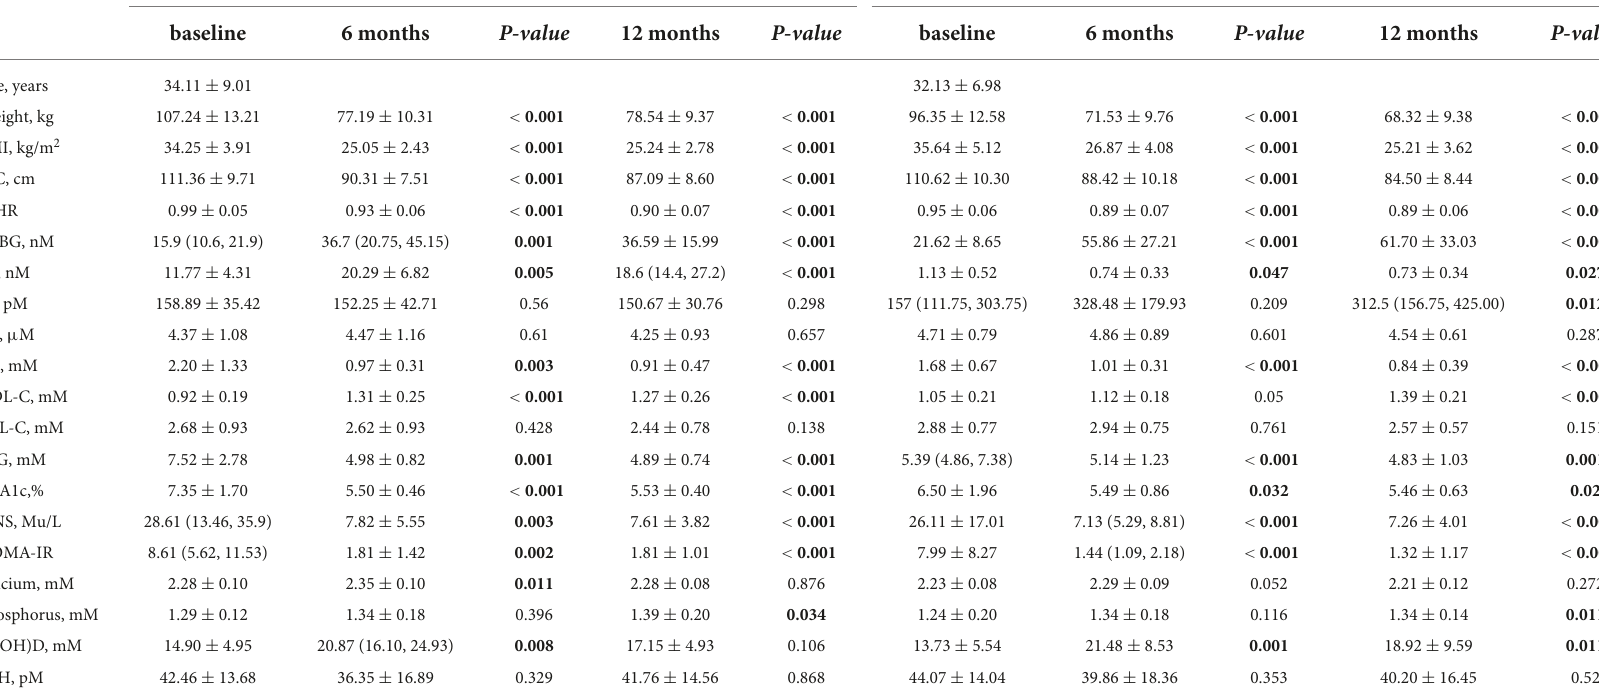
TABLE 1 Clinical characteristics of the participants at baseline and at 6 and 12 months after sleeve